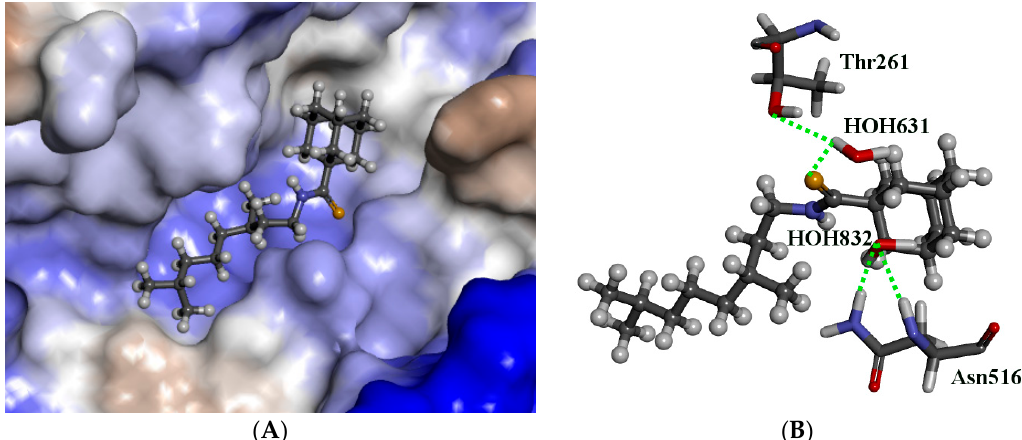
Figure 4. The docked configuration of 46a in the binding site of Tdp1 as predicted using the ChemScore scoring function. ( A ) The protein surface is rendered. The ligand occupies the binding pocket. Blue depicts a hydrophilic region on the surface; brown depicts hydrophobic region and whites shows neutral areas. ( B ) H-bonds are shown as dotted green lines between the sulphur atom and HOH631. The water molecules also form H-bonds with Thr261 and Asn516 .